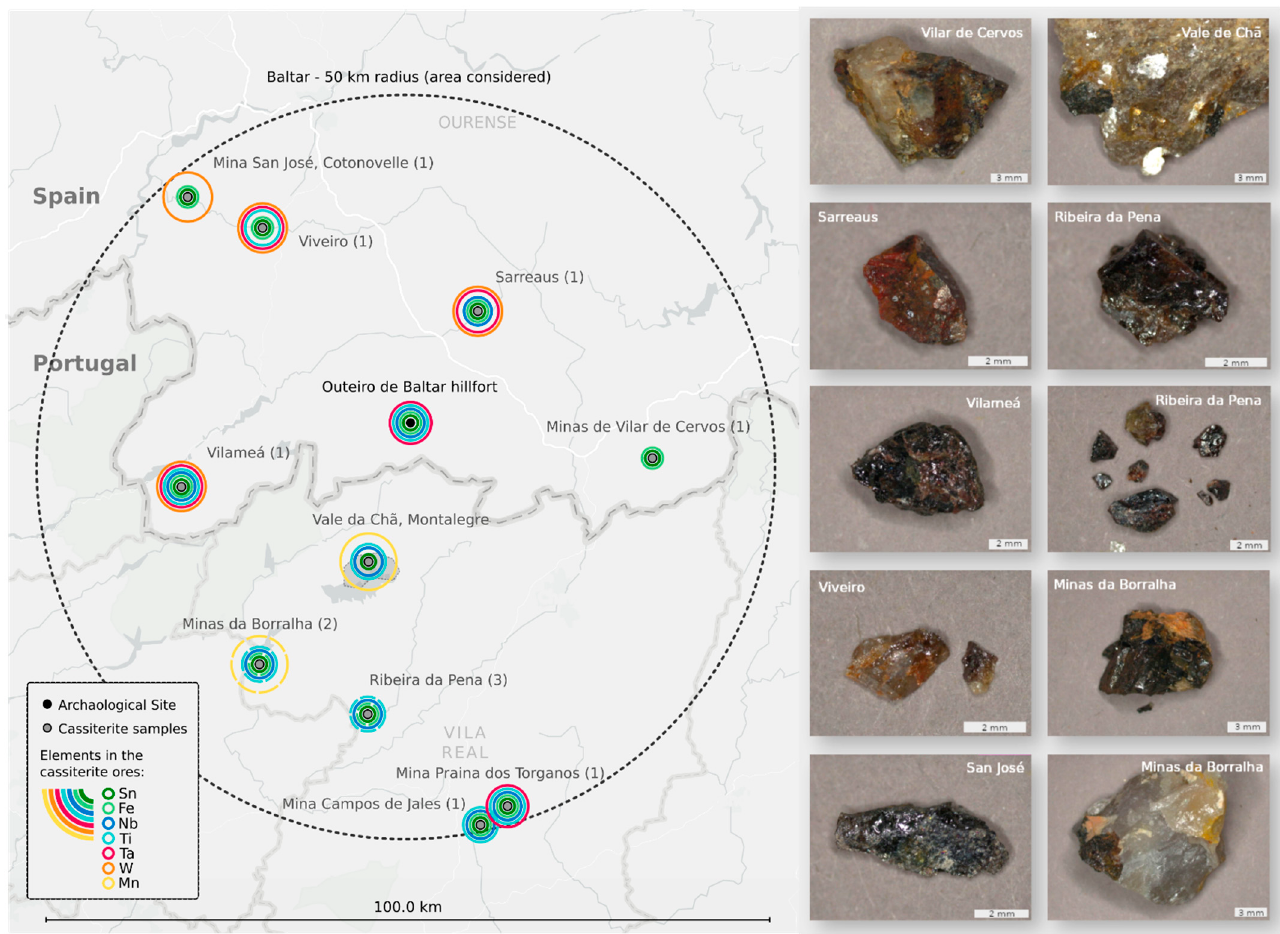
Figure 10. Location of the cassiterite samples analyzed in the present work (50 km radius consid-ered around the Outeiro de Baltar hillfort) with annotation of different elements detected in the samples (based on WDXRF and micro-XRF analyses ( left ); dashed circle lines represent elements that were not always present in all the samples analyzed from one site) and photographs of some samples (on the right ).